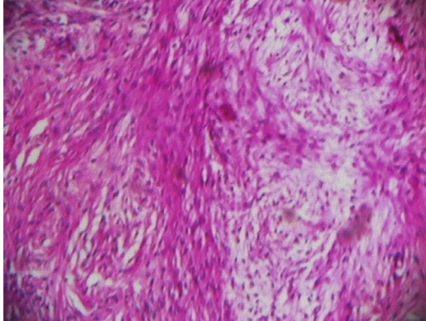
Figure 1: Photograph of gross specimen of right ovarian tumour: solid and cystic mass with smooth surface.